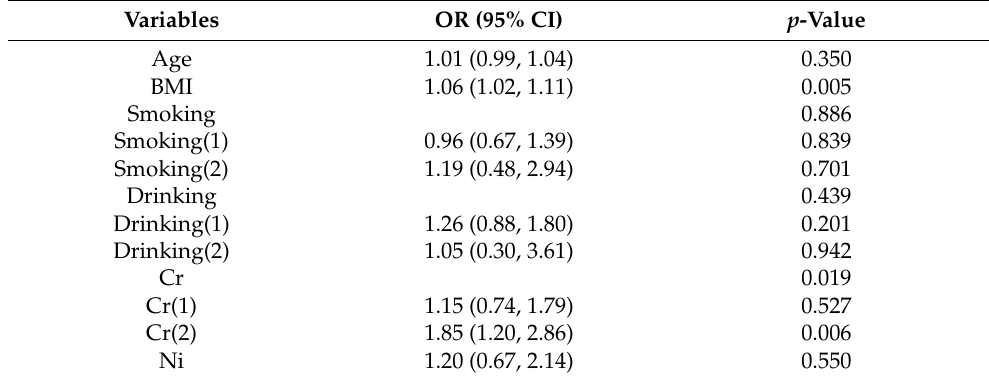
Table 4. Multivariate logistic regression and